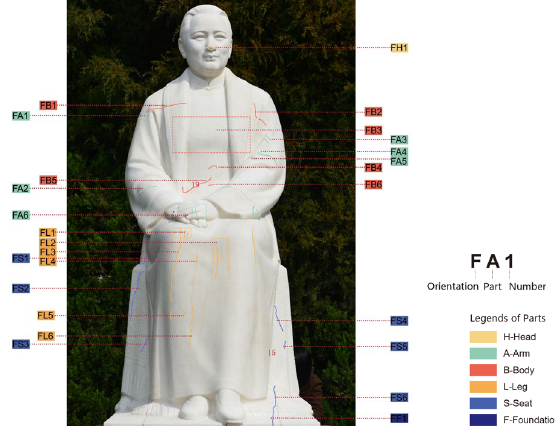
Figure 6 . Mapping of cracks on the front of the statue, with the